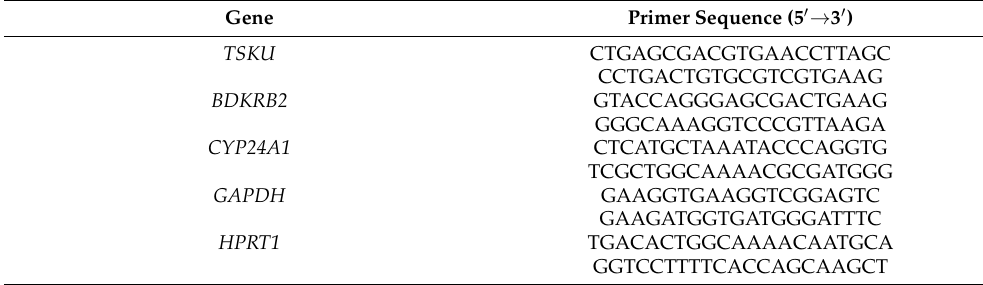
Table 2. Primers used for the real-time